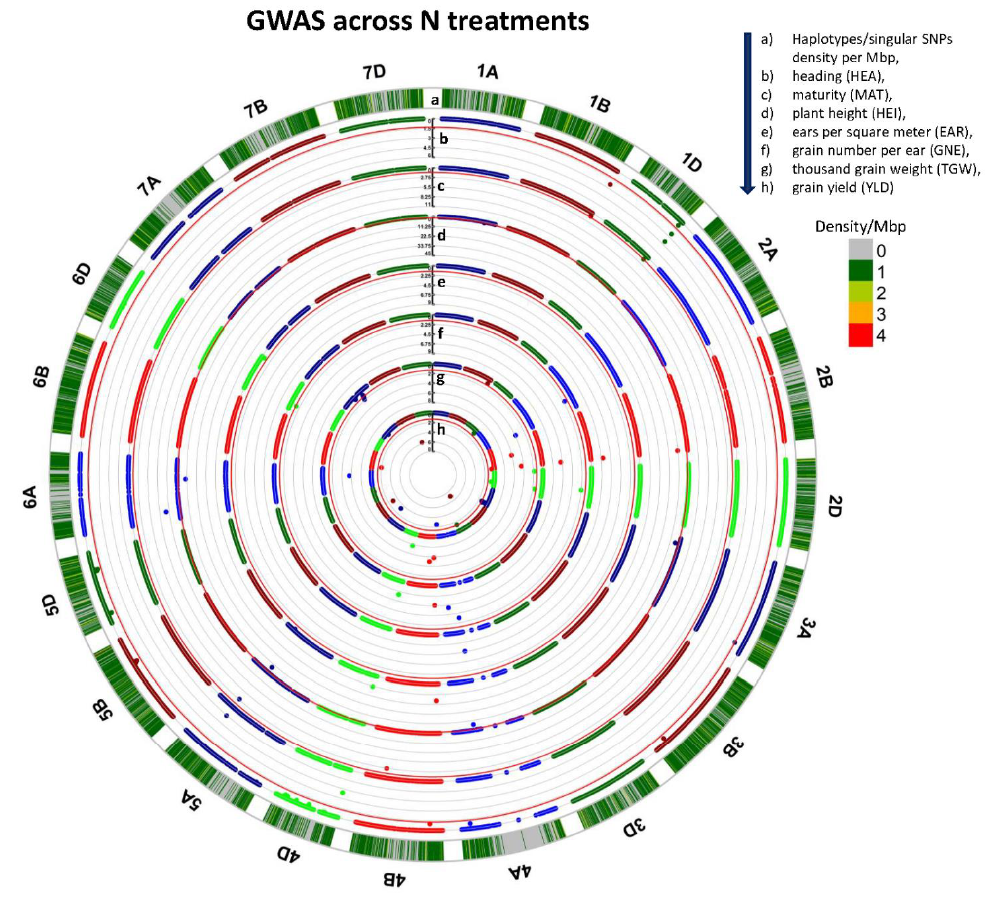
Figure 3. Circular Manhattan plots of genome-wide association scan for seven traits studied in WM-800 across N treatments. Wheat chromosomes are named on the outside of the circos plot. Circle a denotes the number (density) of haplotypes and singular SNPs per Mbp. The following circles b to h denote the GWAS output across N treatments for heading (HEA), maturity (MAT), plant height (HEI), ears per square meter (EAR), grain number per ear (GNE), thousand grain weight (TGW) and grain yield (YLD). The −log 10 BON_ p value of each marker-trait associ- ation is indicated as a colored dot on the vertical scale bar. For each trait, the red circle indicates the significance threshold at BON_ p = 0.05 (i.e., −log 10 BON_ p = 1.301). Table 3. The number of significant marker-trait-associations (MTA) with BON_ p < 0.05 and QTL per trait, given across N treatments and per treatment (N0 and N1).